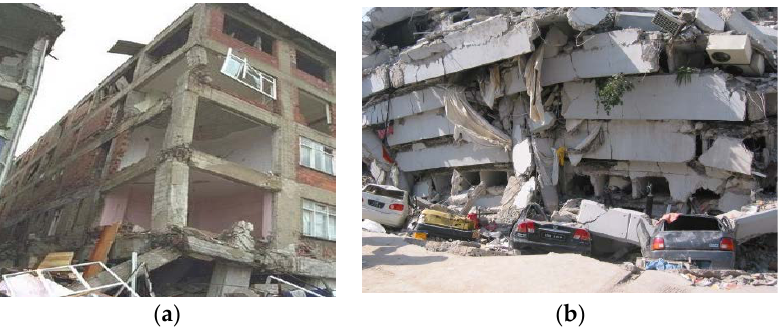
Figure 2. Partial and total panel collapse of RC buildings [3]. ( a ) Building panel partial collapse. ( b ) Building panels total collapse.